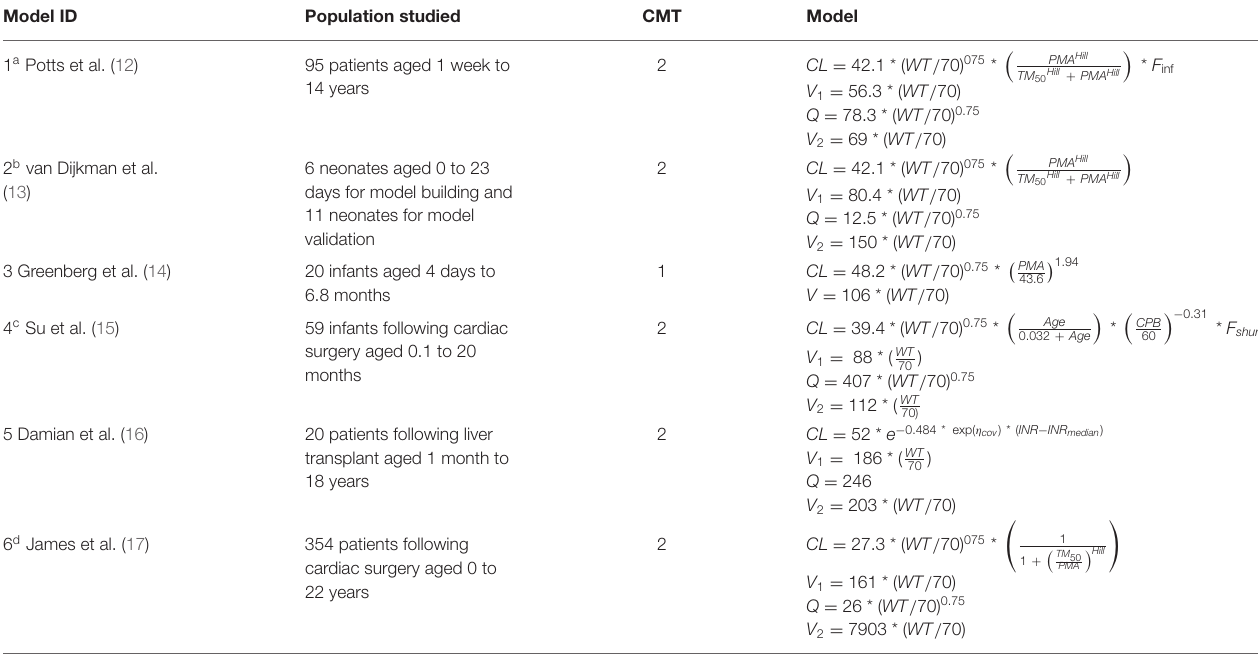
TABLE 1 | Description of the population PK models evaluated. Model